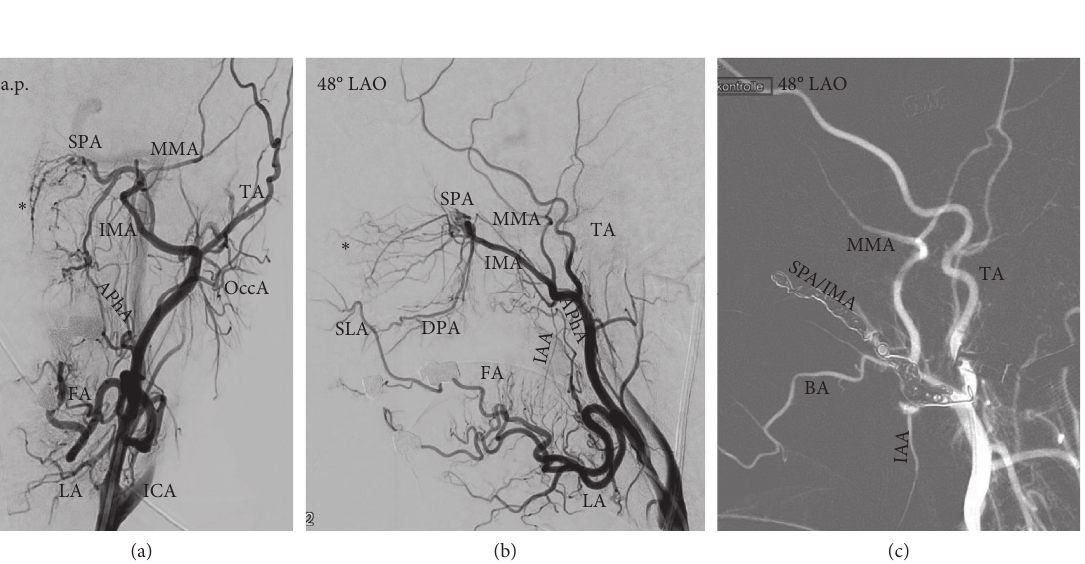
Figure 2: Embolization of the left internal maxillary artery/sphenopalatine artery (IMA/SPA) in a 49-year-old female patient with he- reditary hemorrhagic telangiectasia. A.p. (a) and 48 ° LAO (b, c) Angiogram of left external carotid artery (ECA) shows arterial supply of nasal cavity via IMA. (a, b) Main supply of Kiesselbach’s plexus (asterisk) is provided via SPA, but there also collaterals to the superior labial artery (SLA, a branch of the facial artery FA). (c) Angiogram after embolization with micospheres and coils: there is no contrast flow in the